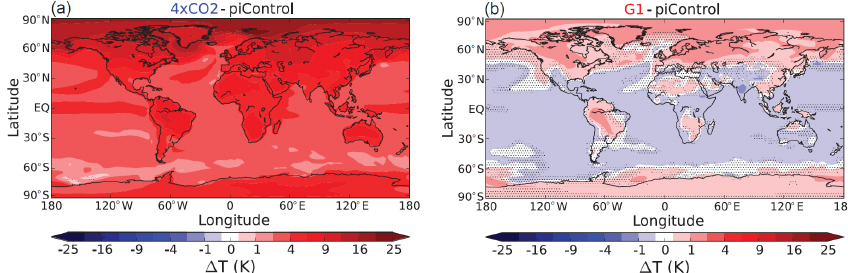
Figure 2. Annual mean surface temperature differences. The differences are based on the average temperatures of the last 50years of each experiment. (a) 4 × CO 2 relative to preindustrial conditions. (b) G1 relative to pre-industrial conditions. Note the non-linear colour scale. Non-significant changes (using a two-tailed Student’s t test at the 95% confidence level) are marked by